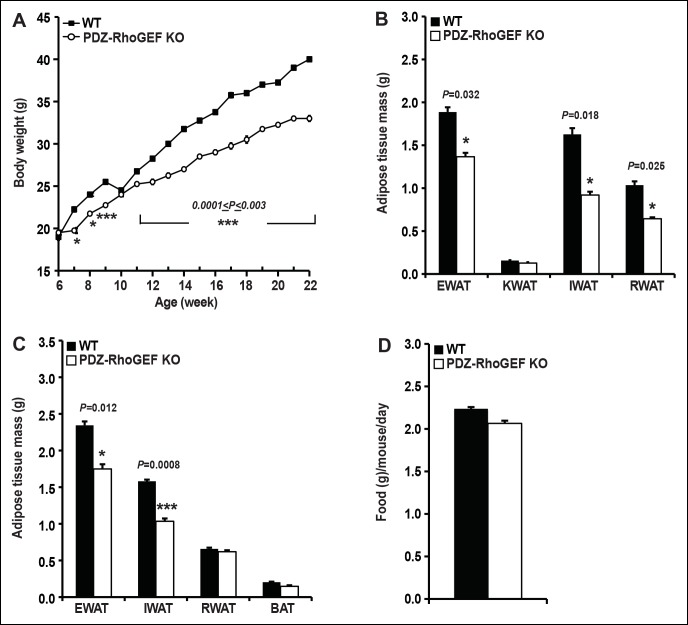
Adiposity and food consumption in WT and PDZ-RhoGEF KO mice under high-fat diet.(A). The body weight of mice switched to HFD at 6-weeks of age was monitored for 16 weeks (n = 4). (B) Anatomical quantification of fat mass from mice of late-onset group after 24 weeks under HFD (n = 8). (C) Anatomical quantification of fat mass from early-onset group after 16 weeks under HFD (n = 4). (D) Food intake in WT and PDZ-RhoGEF KO mice (n = 4). Food intake per mouse was measured every week over 12-week period. Statistical significance was calculated by a Student’s t test using Excel software (*p<0.05, **p<0.01, ***p<0.001).